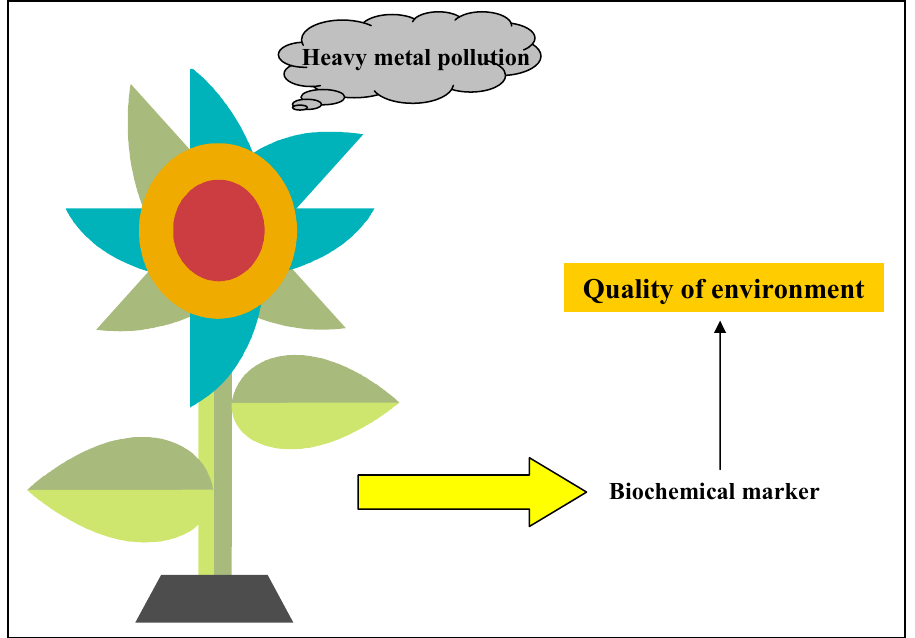
Figure 2. The scheme of environment quality assessment based on determination of biochemical markers presented in